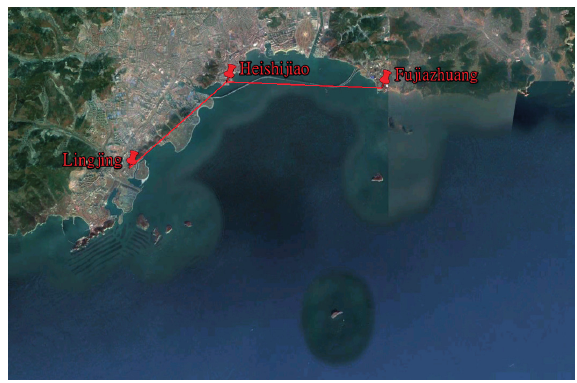
Figure 10. Location distribution of base stations in the verification system.